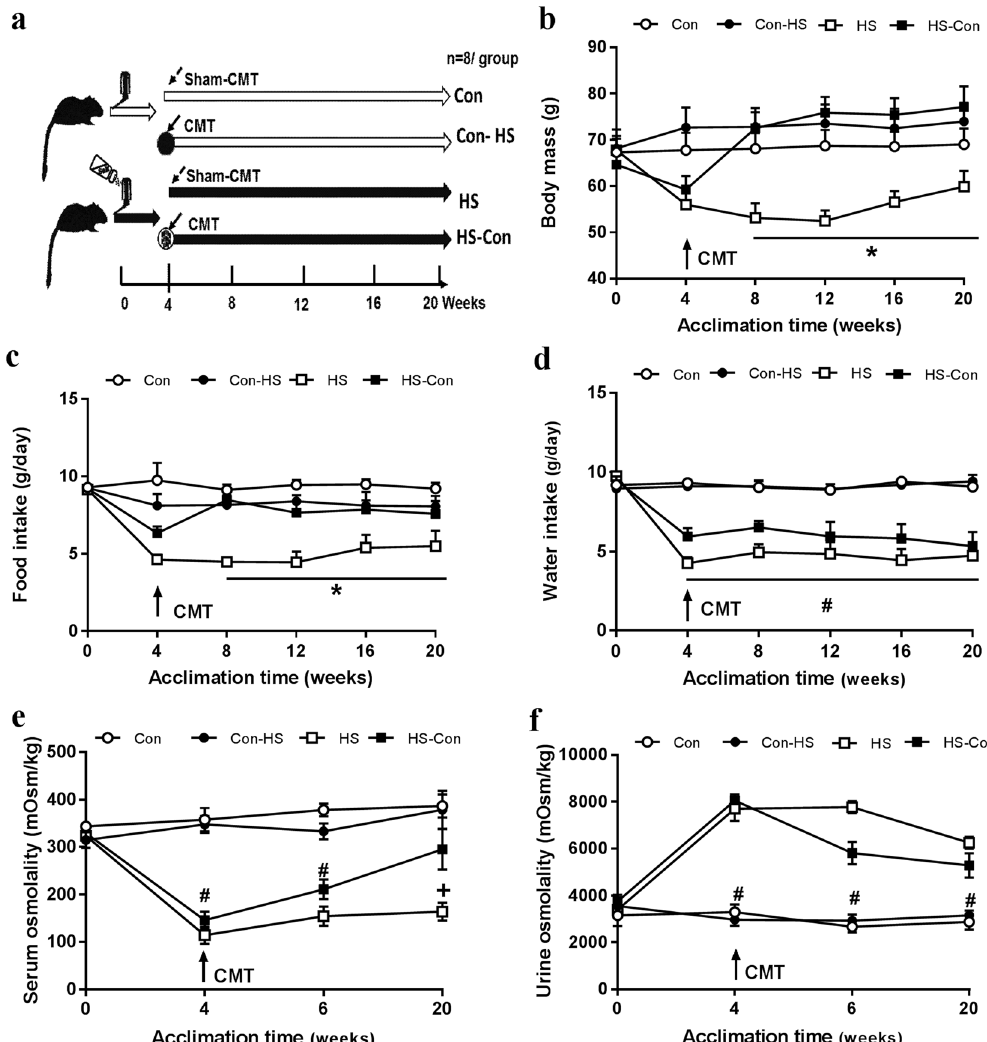
Fig. 2 Microbiota transplant reversed salt-induced changes in energy balance and osmolality. Schematics of experimental design ( a ), body mass ( b ), food intake ( c ), water intake ( d ), serum osmolality ( e ), and urine osmolality ( f ) after caecal microbiota transplant (CMT). * P < 0.05, HS vs other groups (HS-Con, Con and Con-HS); + P < 0.05, HS vs Con and Con-HS; # P < 0.05, both HS and HS-Con vs Con and Con-HS. Data are means ± standard error of the mean (s.e.m). Con, gerbils drank tap water ad libitum and received sterile saline as sham-CMT via oral gavage; Con-HS, Con gerbils received microbiota from HS gerbils via oral gavage; HS, gerbils drank water with 8% NaCl ad libitum and received sterile saline as sham-CMT via oral gavage; HS-Con, gerbils drank HS water ad libitum and received microbiota from the Con gerbils via oral